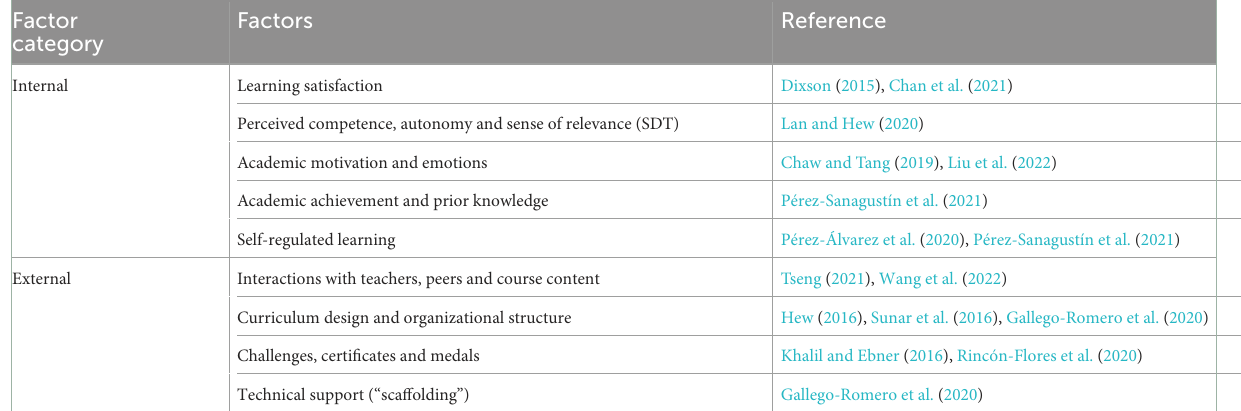
TABLE 13 Factors affecting learning engagement in massive open online